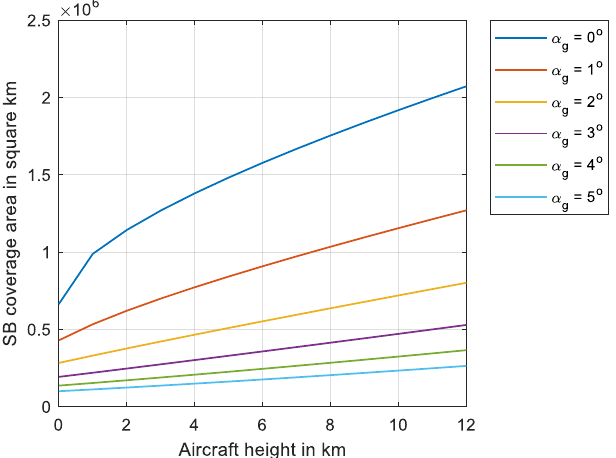
Figure 5. Variation of SB coverage area with the aircraft height at different minimum elevation angles.